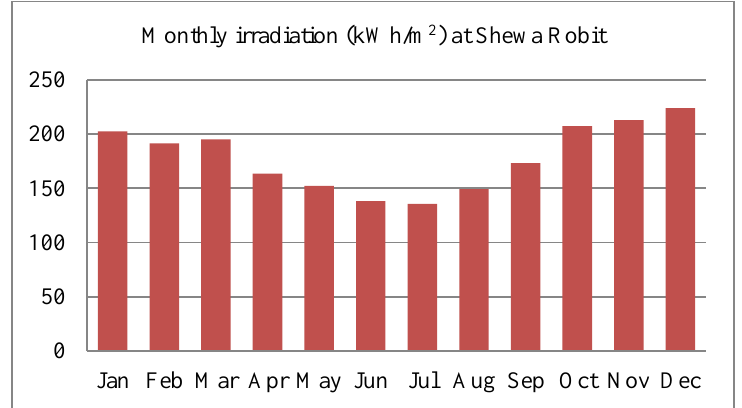
Figure 15. Solar radiation assessment of North Shewa zone at Shewa Robit.